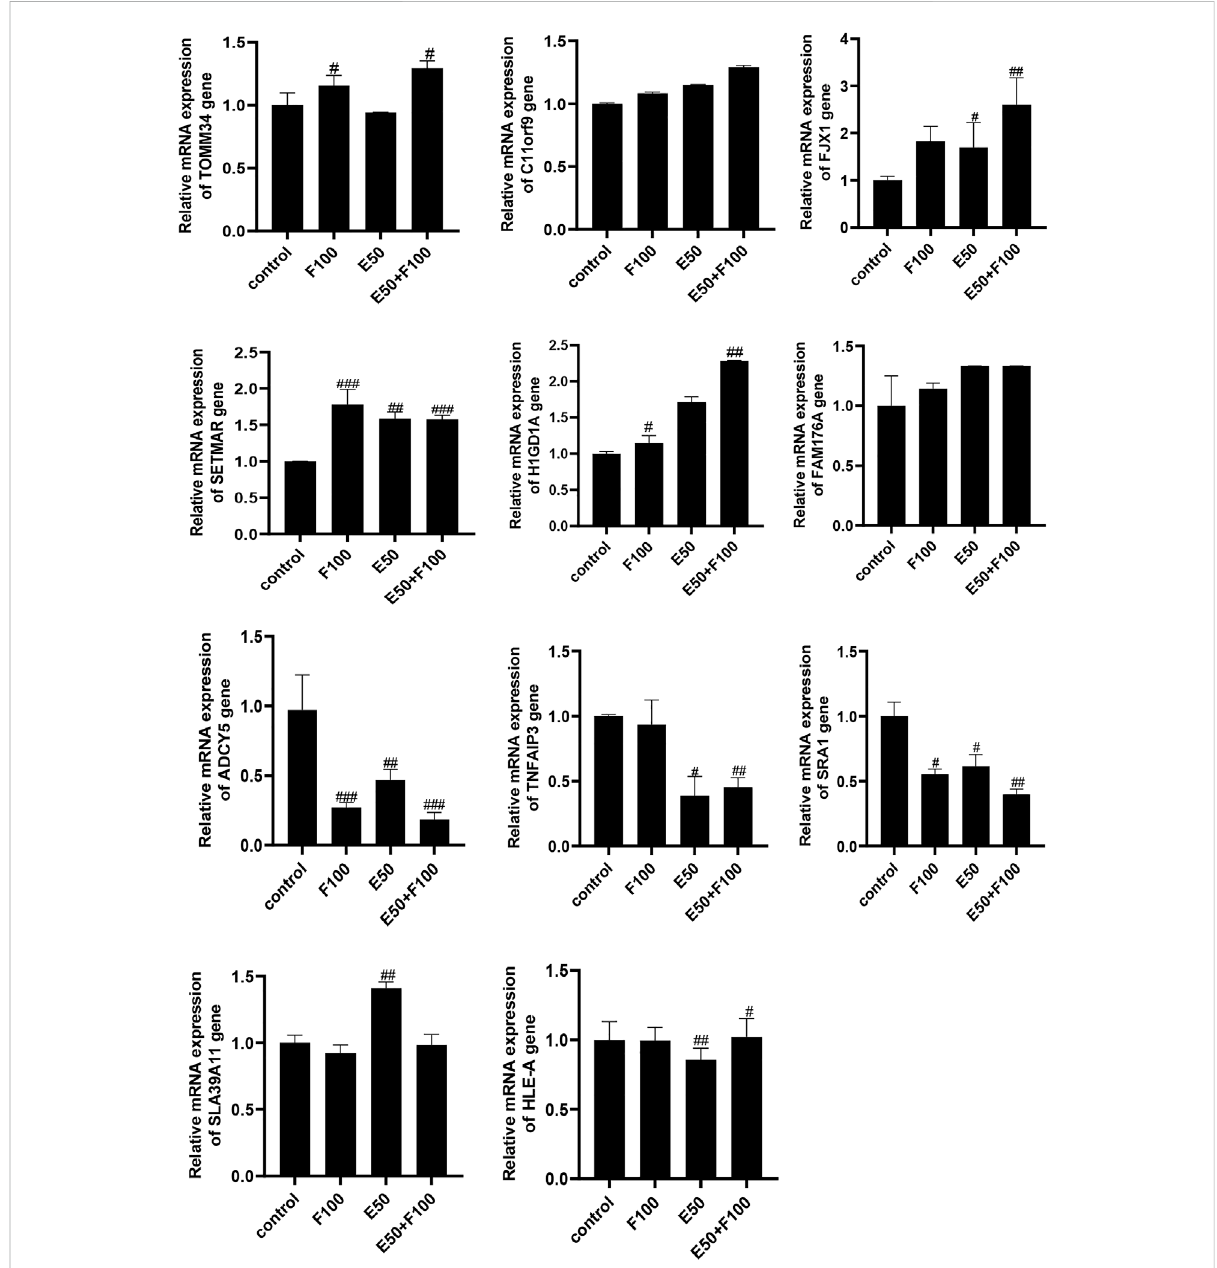
FIGURE 4 Screening of target genes for FZHY inhibiting HBeAg production. Each group vs. control group, # p < 0.05, ## p < 0.01, ### p < 0.001. F100: 100 μ g/ml FZHY, E50: 50 μ g/ml ETV, E50 + F100: 50 μ g/ml ETV +100 μ g/ml